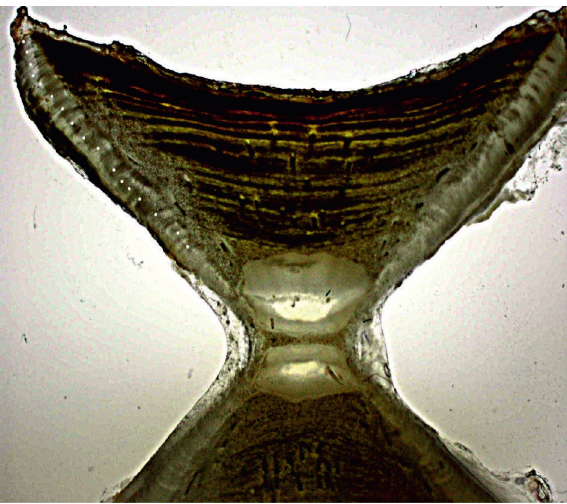
Fig. 2. Longitudinal cross-section of vertebral centrum of Mustelus mustelus (150.2 cm TL, estimated age 17 years) from the Gulf of Iskenderun, north-eastern Mediterranean